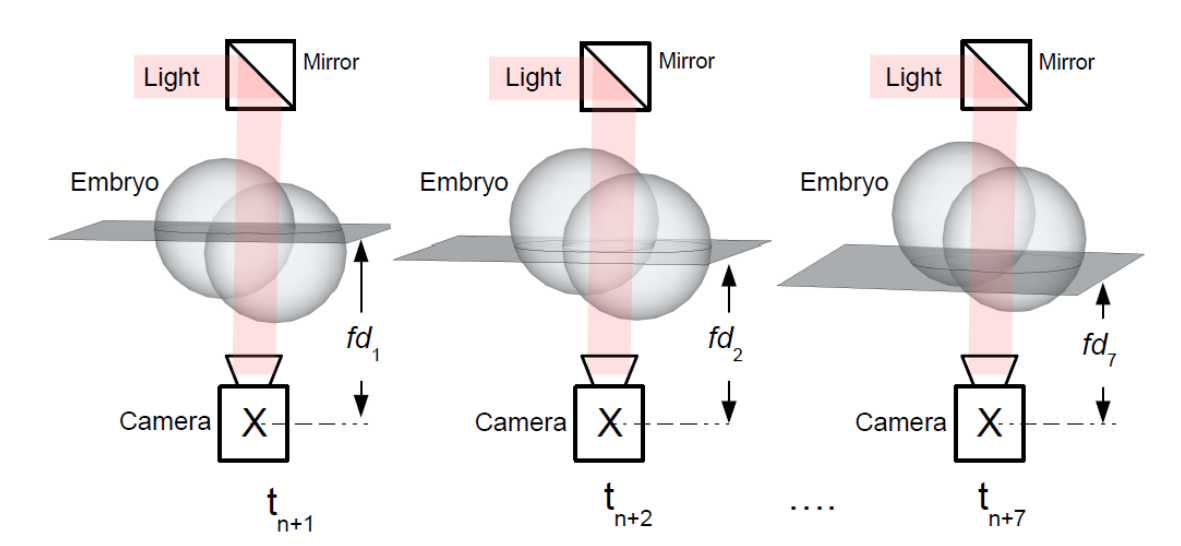
Figure 2. Image capturing